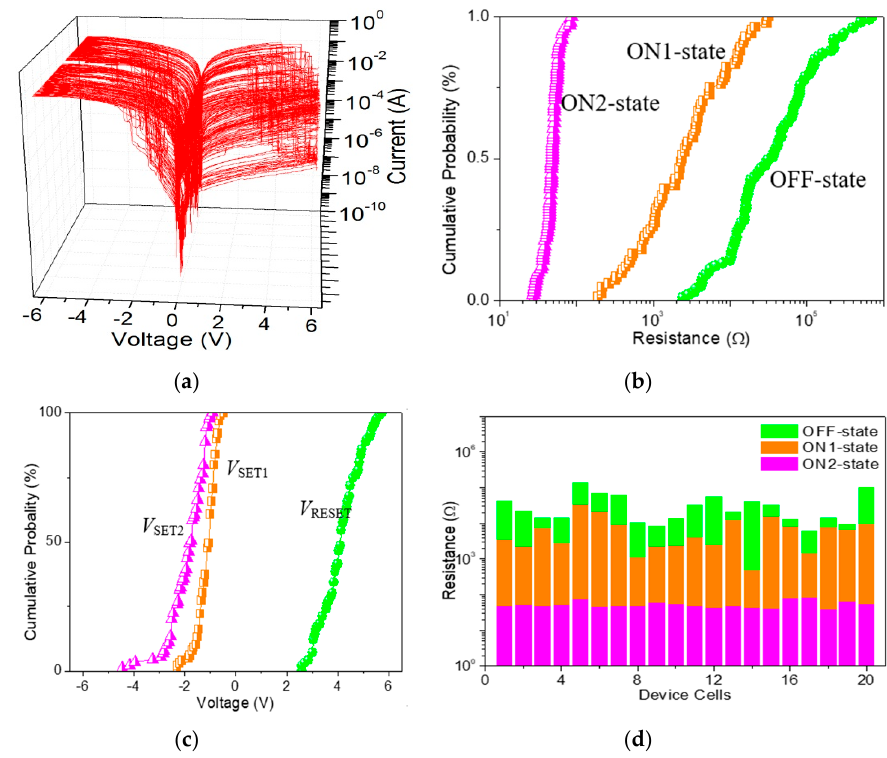
Figure 8. ( a ) 100 tristable sweeping cycles for ITO/GO:0.5 wt%GQDs/Ni; ( b ) Cumulative probability of the resistance in OFF, ON1 and ON2 states ( R OFF , R ON1 and R ON2 ), and ( c ) histograms of the SET1, SET2 and RESET voltage ( V SET1 , V SET2 and V RESET ) with respect to cycle-to-cycle operation in ITO/GO:0.5 wt%GQDs/Ni; ( d ) Device uniformity for 20 ITO/GO:0.5 wt%GQDs/Ni cells concerning R OFF , R ON1 and R ON2 .